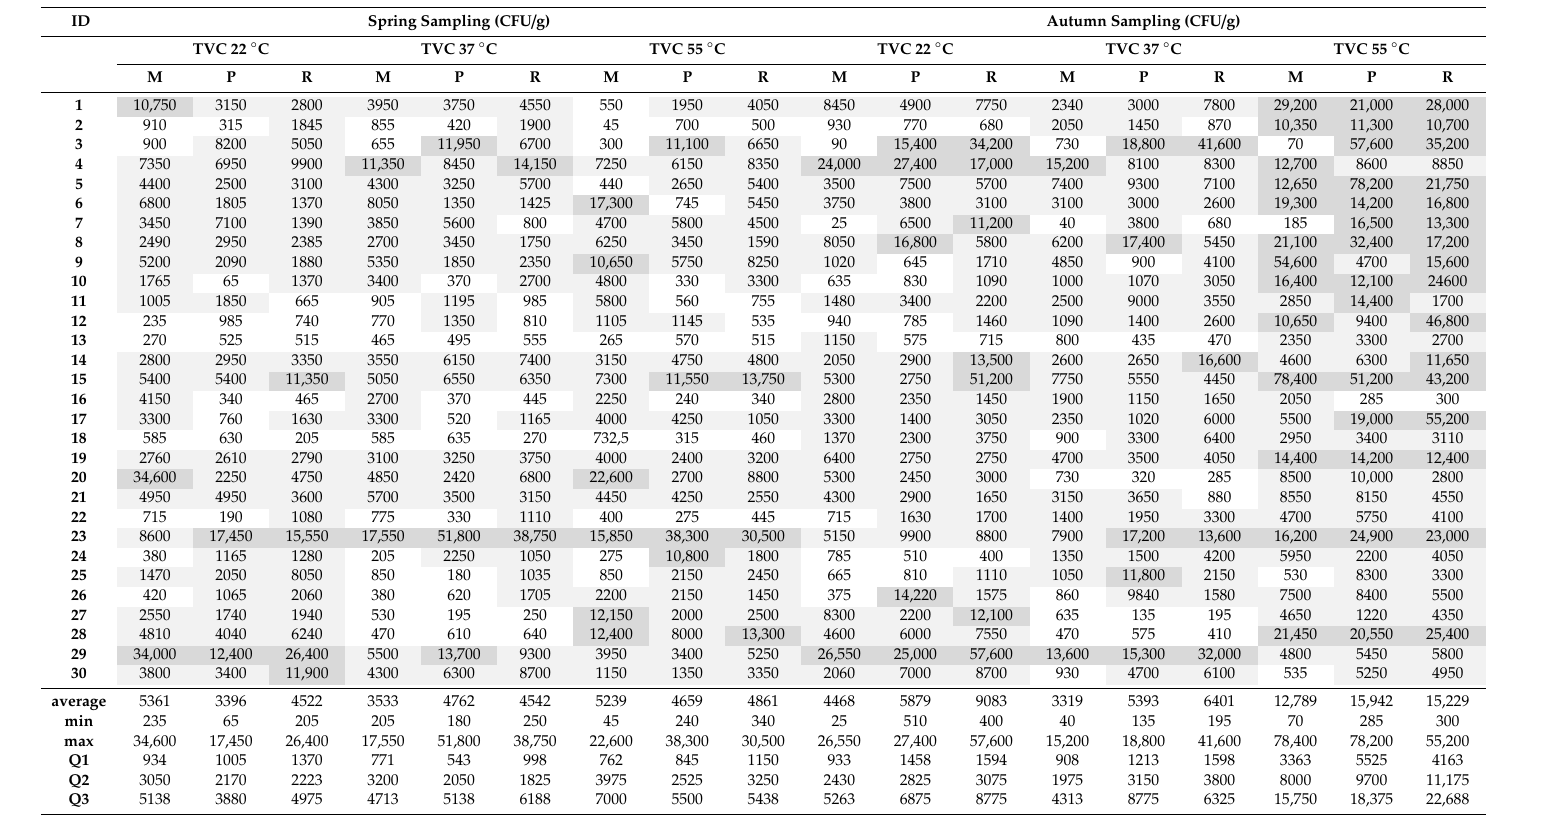
Table 3. Total viable counts (TVCs). Microbial counts at 22, 37 and 55 ◦ C are reported for spring sampling (SS) and autumn sampling (AS) for all three mud typologies (M—maturing mud, P—peloid, R—regenerating used mud). Due to the high variability registered among di ff erent samples (25–78,400 colony forming units (CFU) / g), TVC values are conveniently divided into three classes, each reprised by a white-to-grey gradient. Graphical ranges are: < 10 3 CFU / g (22.6% of samples), 10 3 –10 4 CFU / g (59.4% of samples) and > 10 4 CFU / g (18.0% of samples). Average CFU count, its minimum and maximum values and first (Q1), second (Q2) and third quartile (Q3) are also